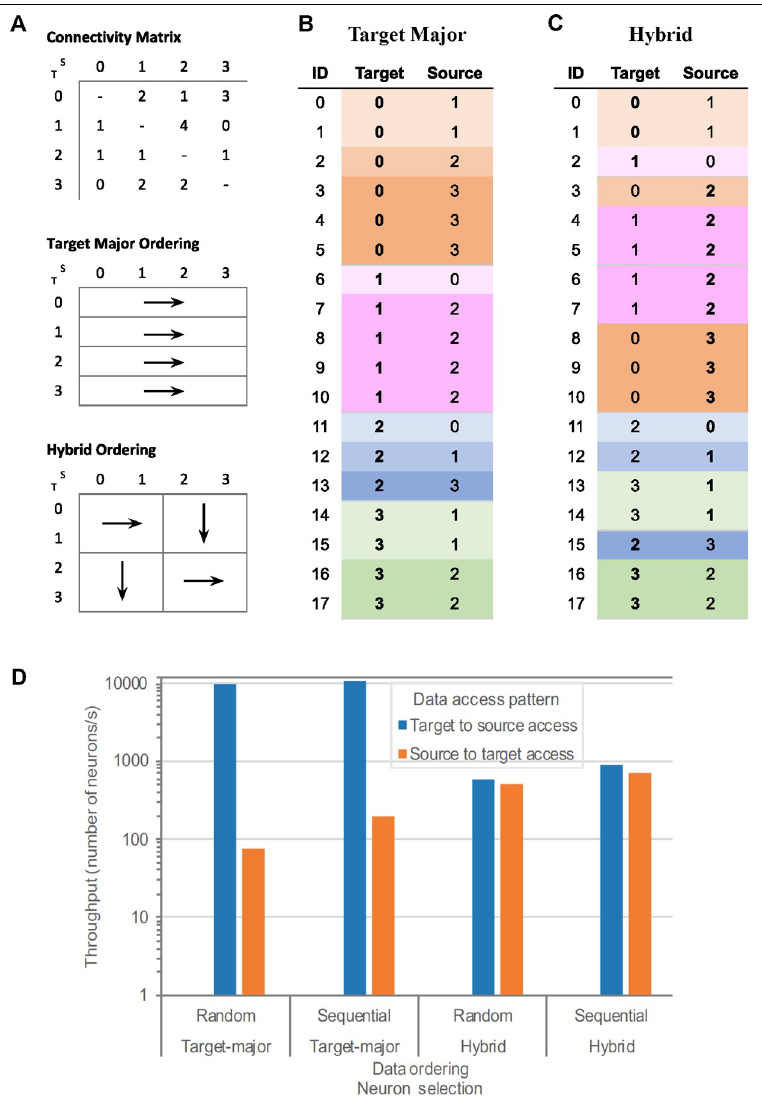
Fig 6. Target major and hybrid ordering of edges. (A) A simple example of connectivity matrix (the number within each matrix element indicates the number of edges—i.e., synapses—between the two nodes) and schematics of target major and hybrid orderings. (B) and (C) Edge lists representing edges from the connectivity matrix in (A), sorted according to target major (B) or hybrid (C) ordering. (D) Throughput of accessing edge information for target major or hybrid ordering of edges in the SONATA files in a 45,000-cell model of Layer 4 of mouse V1[39]. The target-to- source and source-to-target access patterns are illustrated with either random or sequential selection of target or source